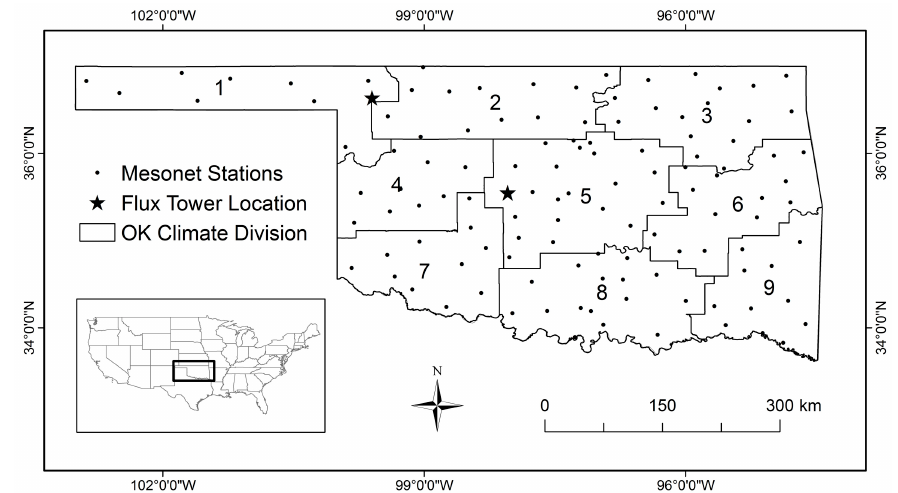
Figure 1. Map of Oklahoma and its nine climate divisions. The locations of Mesonet stations and flux towers are also